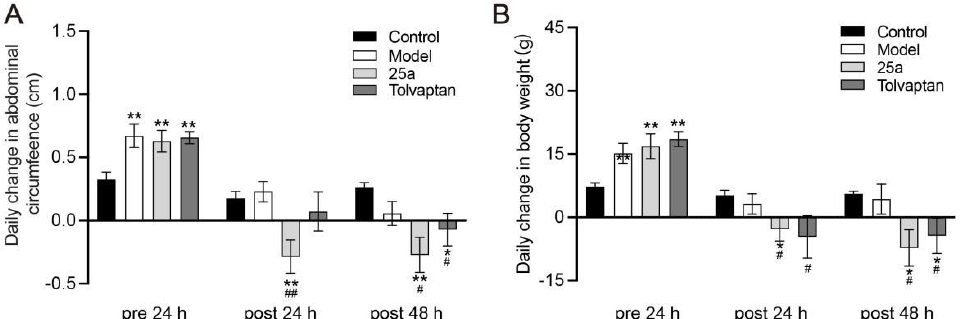
Figure 1. Daily abdominal circumference change and daily body weight change in rats. ( A ) Daily change in abdominal circumference. ( B ) Daily change in body weight. Data are presented as means ± SEM, n = 7. * p < 0.05 and ** p < 0.01 vs. control group; # p < 0.05 and ## p < 0.01 vs. model group. The data were analyzed by one-way ANOVA with Tukey’s HSD post hoc test.